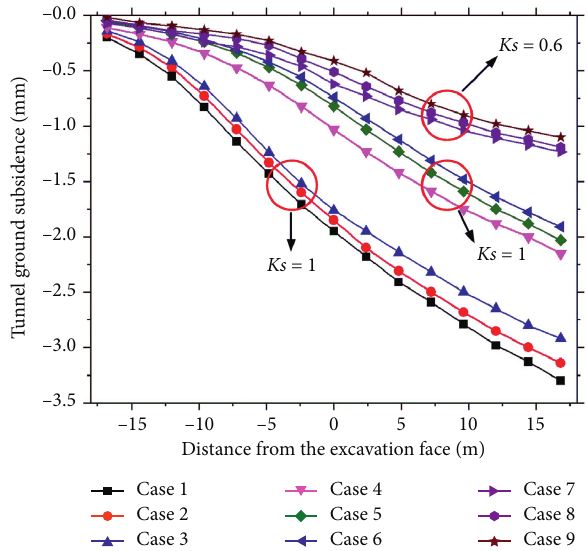
Figure 15: Settlement of measuring point A of the adjacent building under different working conditions.